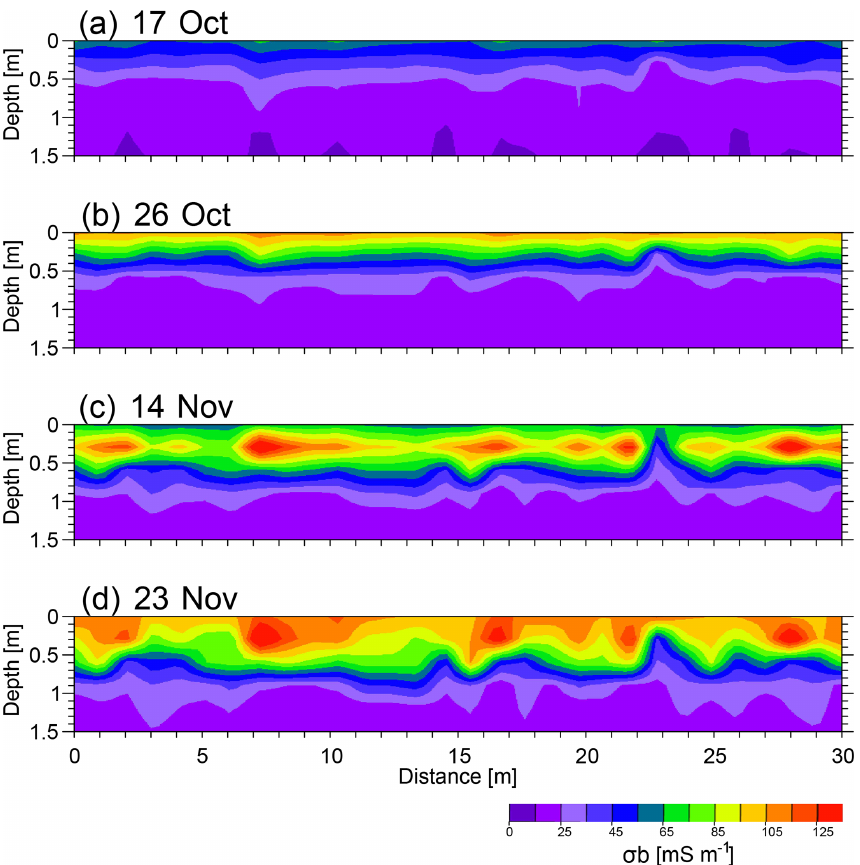
Figure 8. σ b distribution simulations for the selected scenario: (a) 17 October, (b) 26 October, (c) 14 November and (d) 23 November 2016.